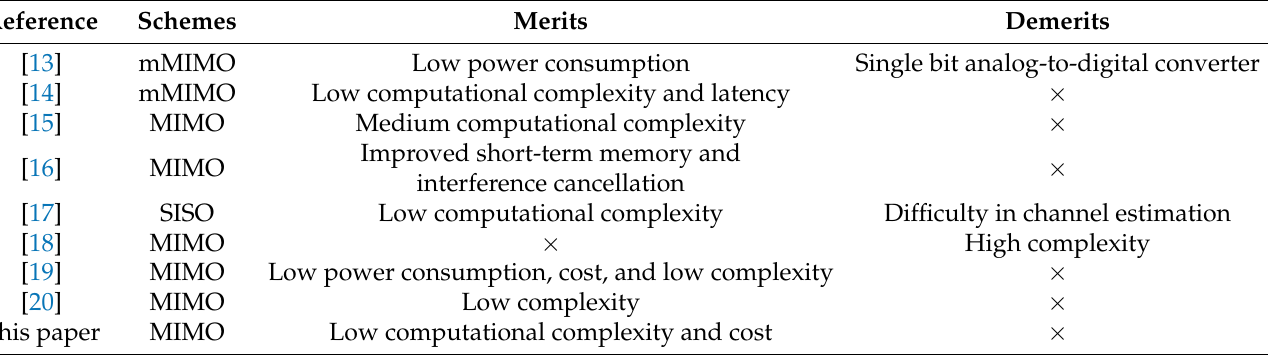
Table 1. Summary of related technologies, merits, and